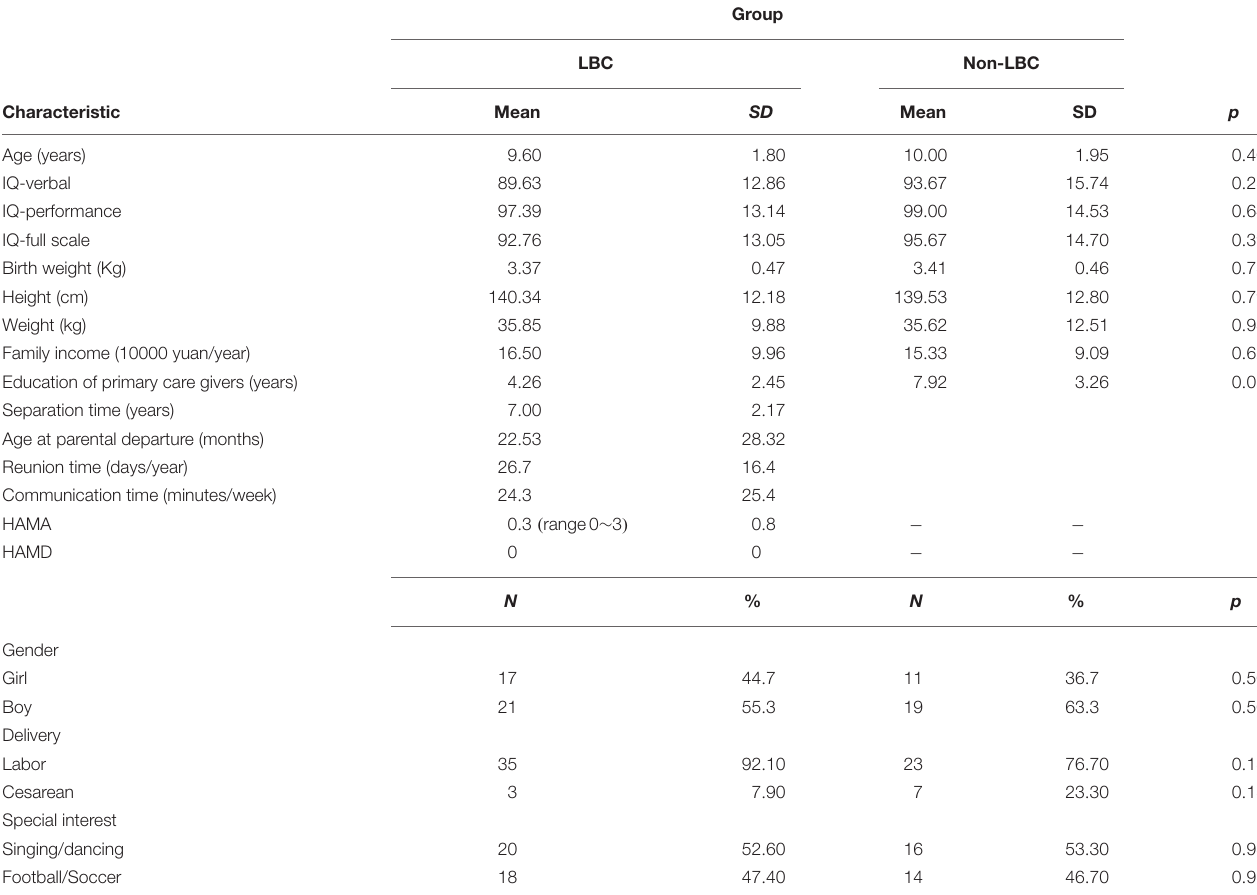
TABLE 1 | Demographic characteristics of left-behind children (LBC) and parentally reared children (non-LBC).